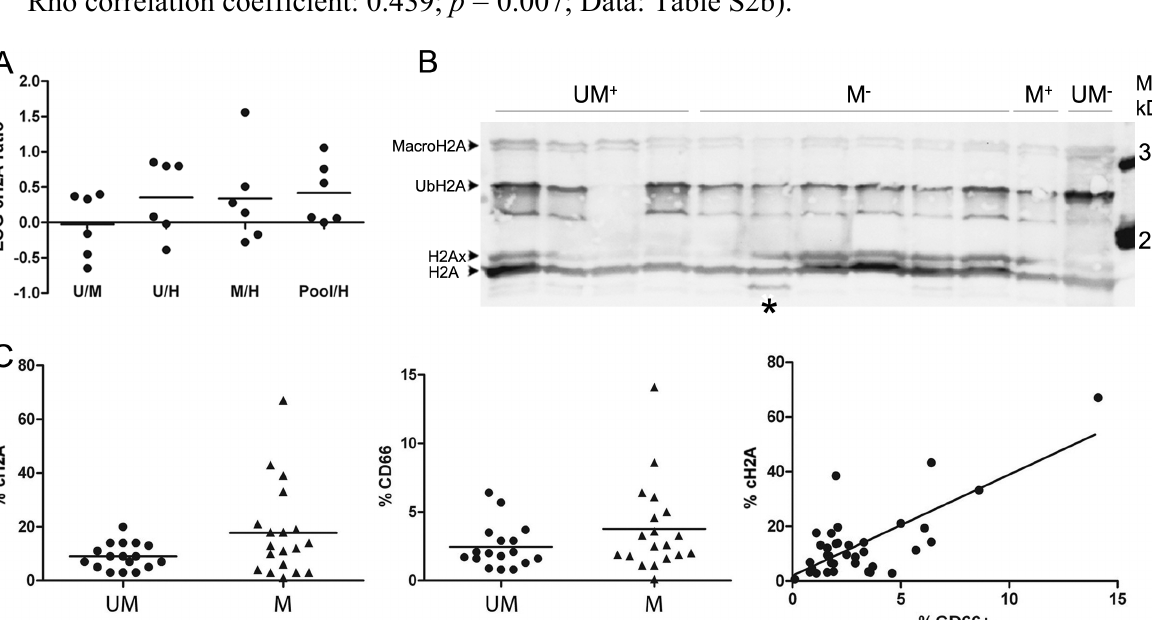
Figure 2. Quantitative mass spectrometry and Western blot analysis on CLL samples revealed that histone H2A clipping is from myeloid origin. ( A ) The iTRAQ ratios of the cH2A peptide (normalized to the average of the H2A protein to compensate for morphological differences) hint towards an increased abundance in CLL compared to healthy B-cells. The individual log ratios of all six runs are presented as dots, the average ratios as the horizontal bars. Histone H2A (cH2A) is up-regulated in the samples of the leukemia pool compared to the samples of the healthy B-cells in all six runs; ( B ) The histone extracts from 12 of the 36 samples (From left to right: patient samples UM + 8, 9, 10 and 11; M − 9, 10, 11, 12, 13 and 14; M + 5 and UM − 6). Western blot with an H2A antibody against the epitope depicted in Figure 1 detects the H2A variants H2Ax, Ubiquitinated H2A and macroH2A. The band under ubiquitinated H2A could not be identified. cH2A was only faintly detected, except for one sample ( * ); ( C ) Specific cH2A screening with AQUA peptides and flow cytometry data revealed the myeloid characteristic of the clipping. Left panel : %cH2A differs significantly ( p = 0.049) between CLL patients with a distinct Although not significant ( p = 0.15), the %CD66b suggested a similar correlation with the mutational status; Right panel : Relation between %cH2a and %CD66b. Spearman’s Rho correlation between CD66b + and %cH2A was significant at the 0.01 level (Spearman’s Rho correlation coefficient: 0.439; p = 0.007; Data: Table